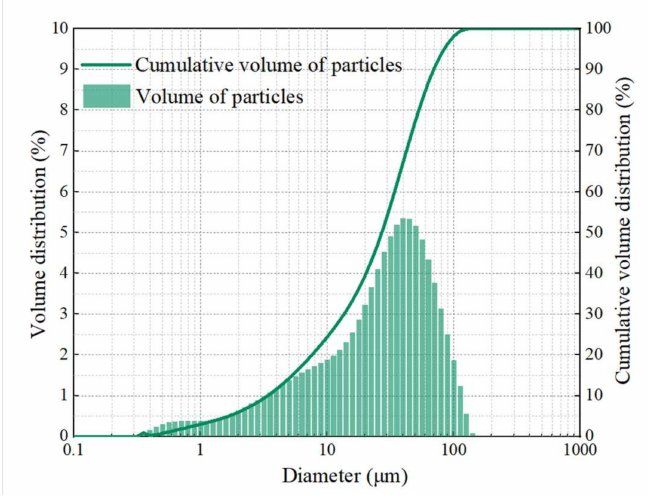
Figure 1. Particle size distribution of MFA. Table 1. Chemical compositions of MFA.